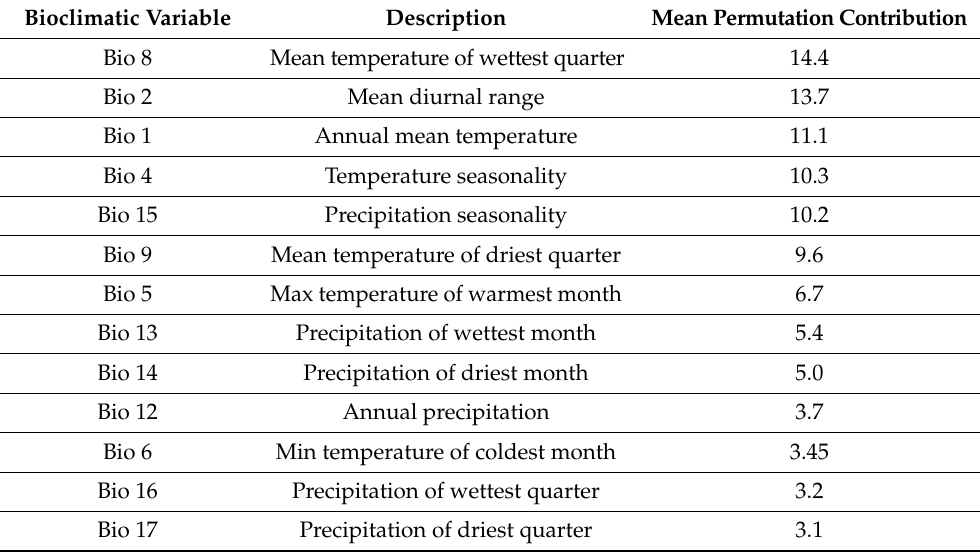
Table 1. Description of predictor variables included in our SDM modeling framework, and the mean permutation contribution of each variable averaged across all our top models. Bioclimatic Variable